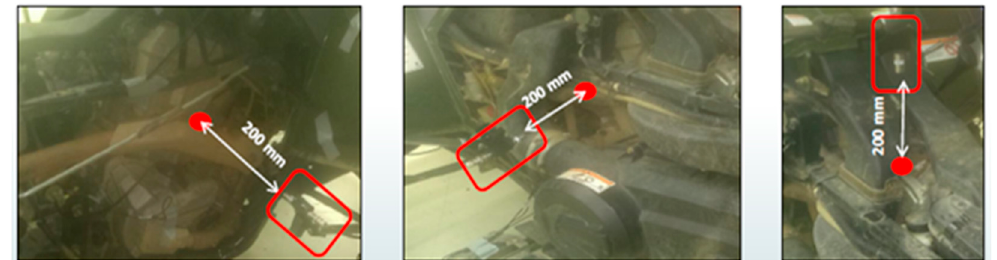
Figure 2. Microphone positions for NVH Test.